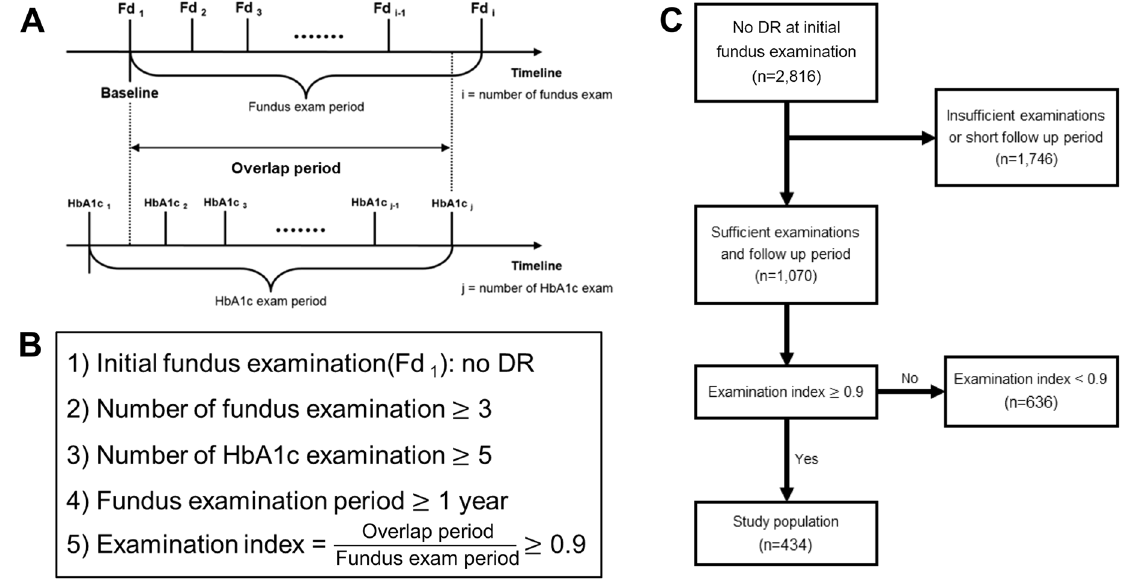
Figure 1. Schematic diagram for study design, inclusion criteria, and study flow chart. ( A ) Study design and timeline of the study. The date of the first fundus examination was designated as the baseline. The overlap period was defined as the length of the period when both serial fundus examination for diabetic retinopathy (DR) screening and serial HbA1c measurement were performed. ( B ) Inclusion criteria. The examination index was defined as the ratio of the overlap period to the fundus examination period, and in this study, only those with an examination index over 0.9 were included. ( C ) Study flow chart. After excluding those with insufficient examinations or a short follow-up period, 434 subjects were finally enrolled in this